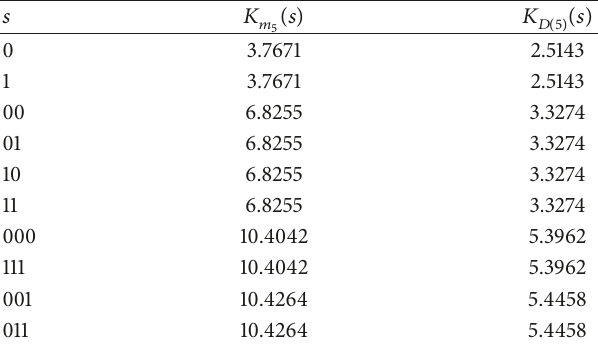
Table 1: Top 10 strings in 𝑚 5 and 𝐷(5) with their estimated